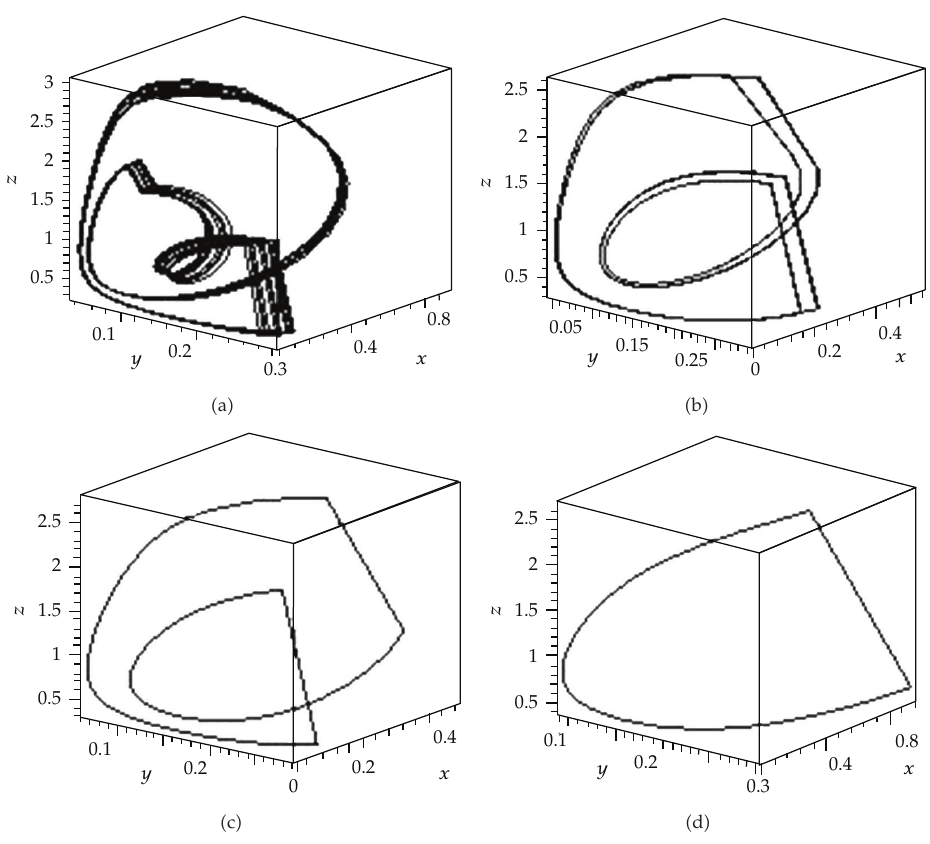
Figure 4: Period-halving bifurcation. (cid:5) a (cid:6) Chaotic attractor when p (cid:7) 1 . 3, (cid:5) b (cid:6) phase diagram of a 4T-periodic solution when p (cid:7) 1 . 55, (cid:5) c (cid:6) phase diagram of a 2T-periodic solution when p (cid:7) 2, and (cid:5) d (cid:6) a period-T attractor when p (cid:7) 2 . 5.